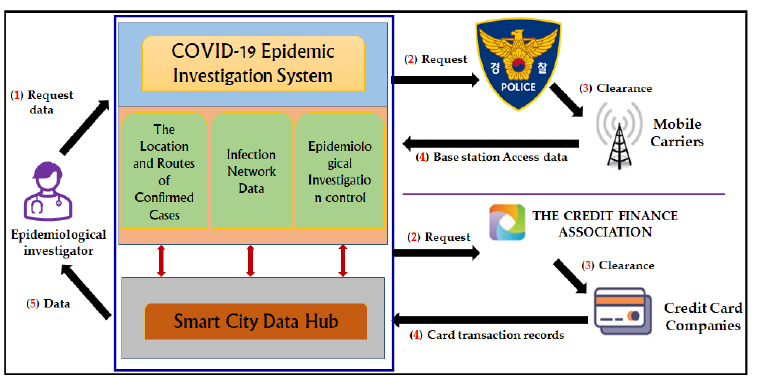
Figure 1. Overview of the EISS developed by Korea to fight the COVID-19 (Adopted from